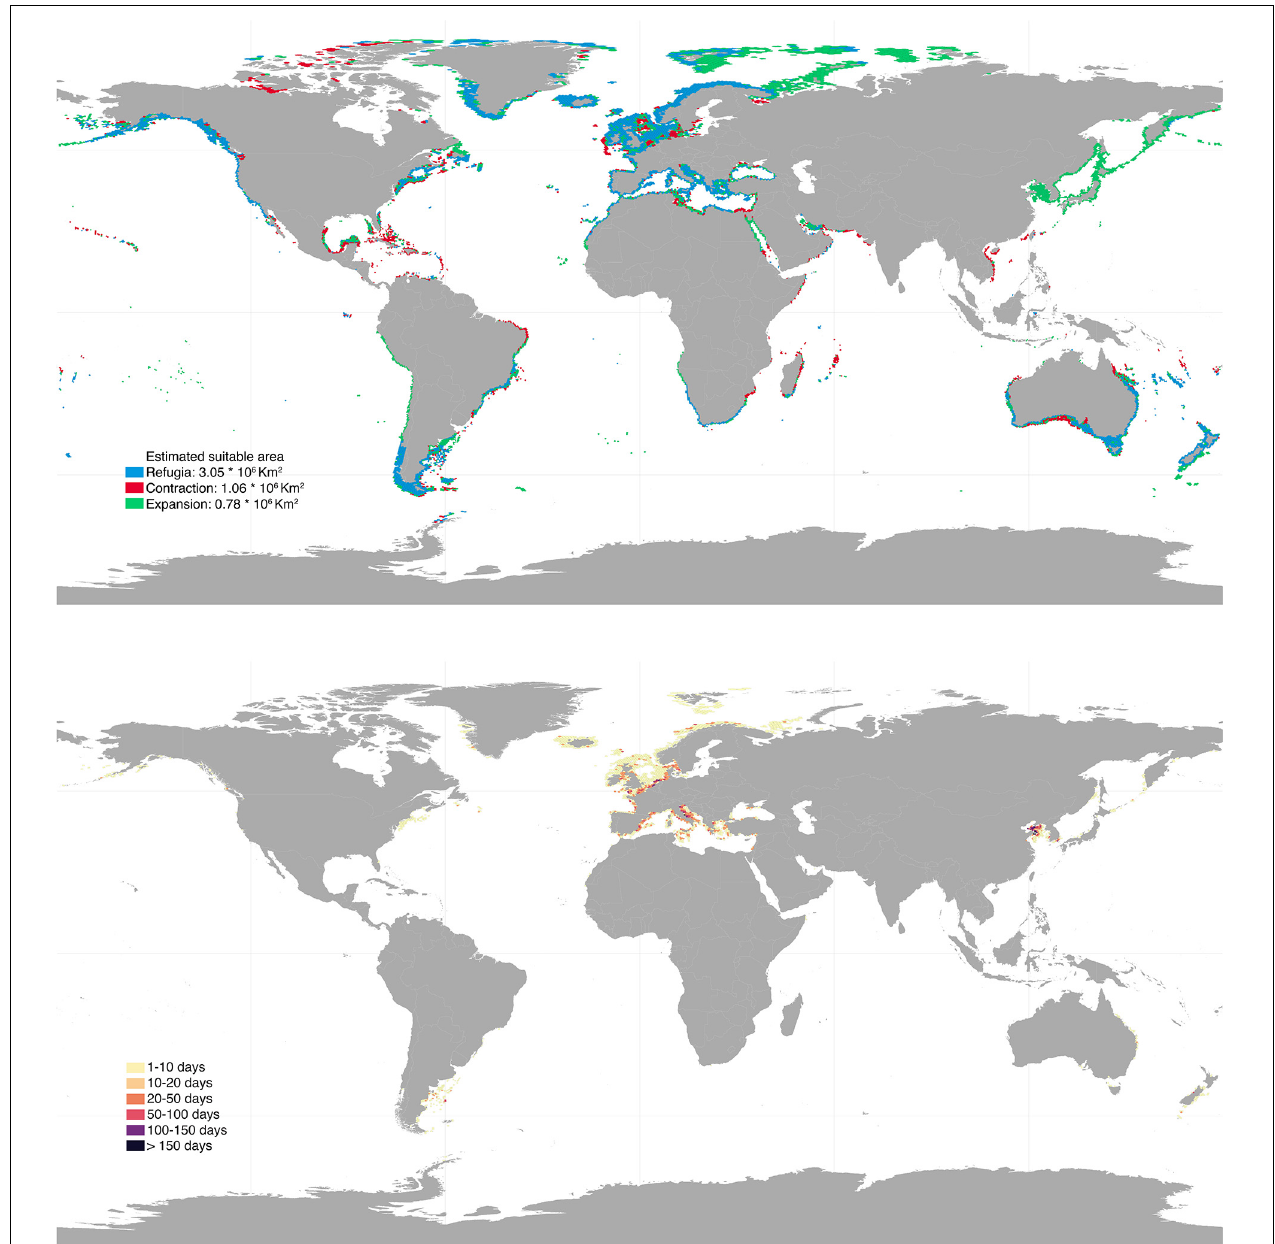
FIGURE 3 | Upper panel: global projected future distribution for rhodoliths under RCP 2.6 scenario. Blue, red, and green colors depict regions of refugia, range contraction and range expansion, respectively. Bottom panel: bottom trawling intensity (days per year) overlaying rhodolith suitable habitats under RCP 2.6. Results were aggregated for better visualization. High resolution maps can be found in Supplementary Material